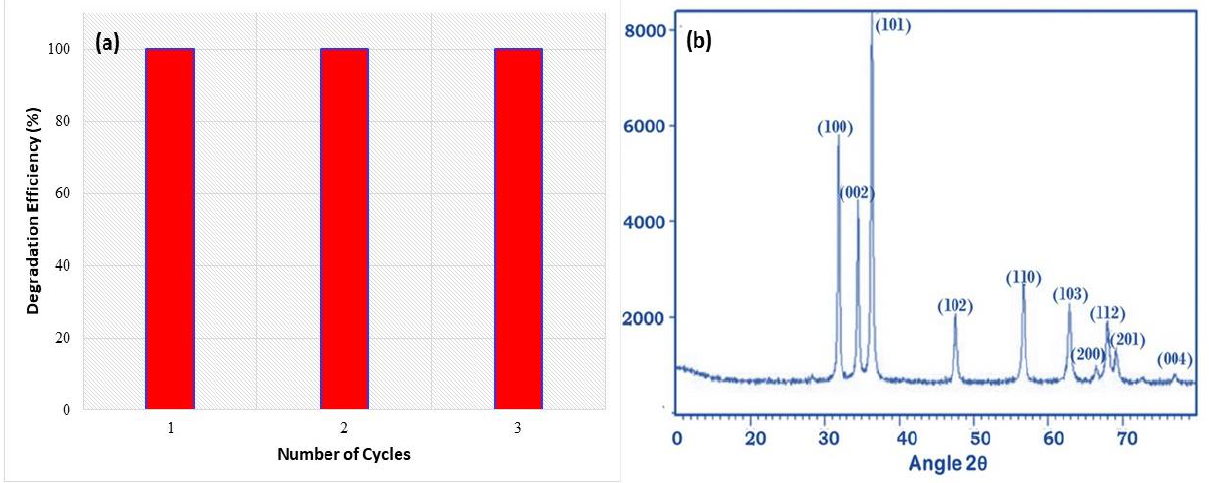
Figure 9. ( a ) The degradation profile of ZnO-NPs for three cycles and ( b ) XRD of ZnO after three cycles.